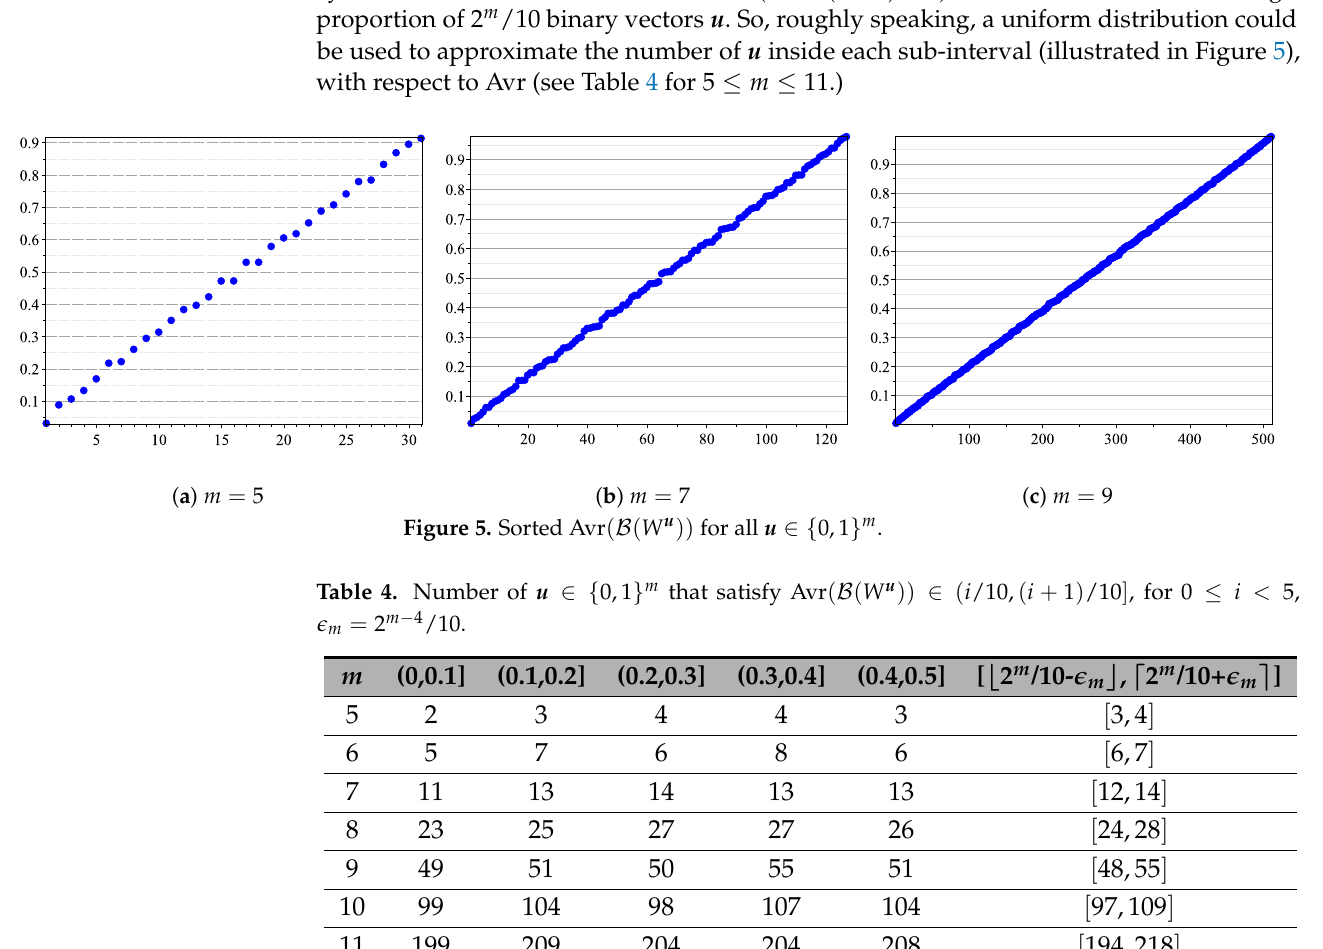
Table 4. Number of u